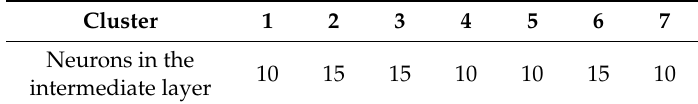
Table 3. Composition of the intermediate layer of the models with the best performance per cluster.